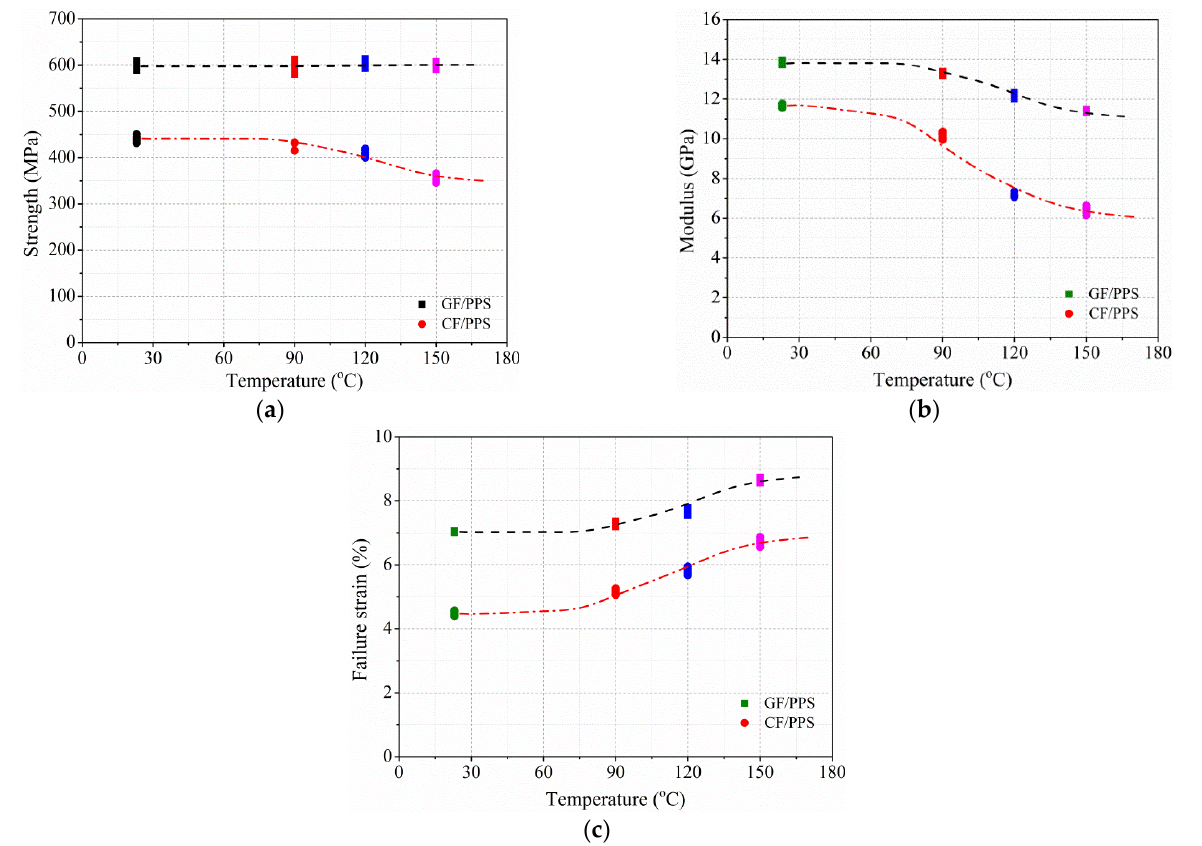
Figure 7. Dynamic properties of two thermoplastic composites in out-of-plane direction at different temperature levels (at 1450/s). ( a ) Strength; ( b ) modulus; ( c ) failure strain.